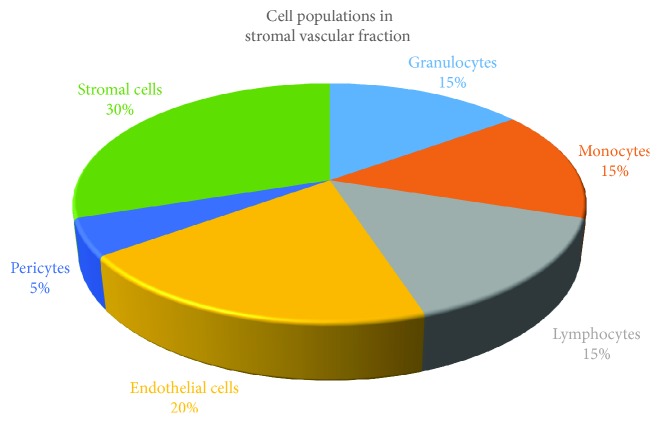
Cell populations in stromal vascular fraction (SVF) [14]. The SVF contains a heterogeneous mesenchymal cell population, e.g., cells of endothelial, hematopoietic, and pericytic origin, among others. Cells of hematopoietic origin include granulocytes (15%), monocytes (15%), lymphocytes (15%), and stem and progenitor cells (<0.1%). Additionally, endothelial cells (20%), pericytes (50%), and stromal cells (30%) are found in SVF.